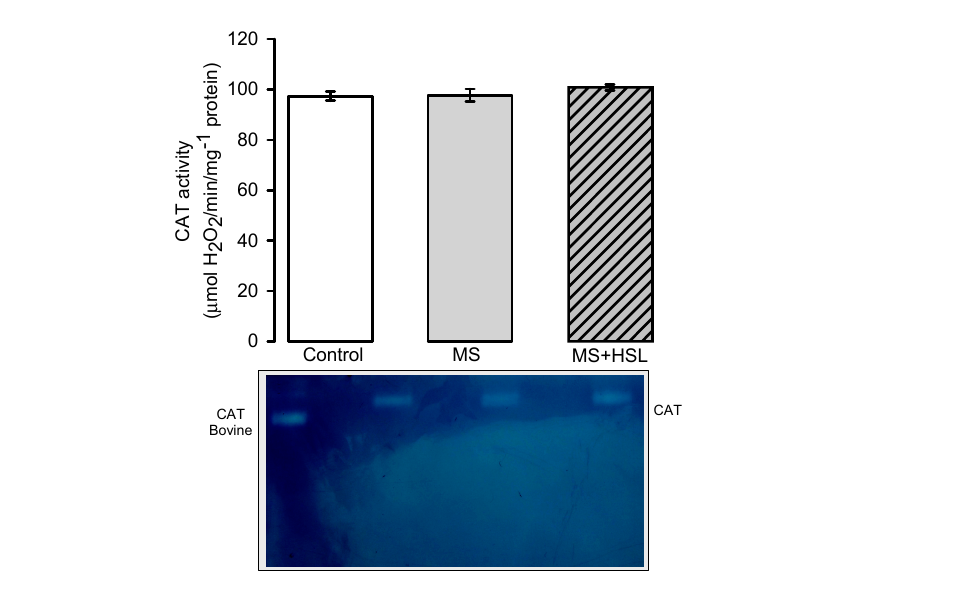
Figure 4. Densitophotometric analysis of the activity of catalase in the kidney homogenate. Below the histogram, a native representative gel of the CAT activity is included. Abbreviations: CAT = catalase, MS = metabolic syndrome, MS+HSL = metabolic syndrome plus Hibiscus sabdariffa L . Data are expressed in means ± SE, (n = 8, rats in each group).